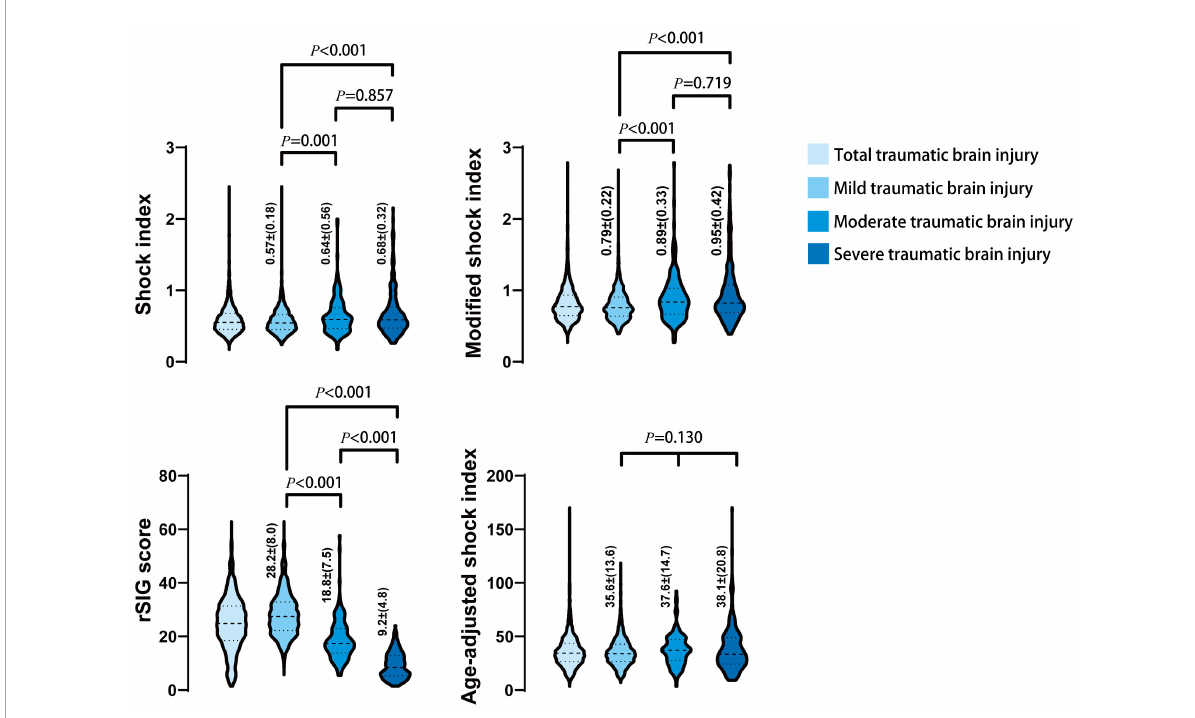
FIGURE3 The distribution and density of four prediction score systems in different severity of traumatic brain injury groups was illustrated in violin plot. Inside the violin plot interquartile ranges and outlier whiskers are presented as a thick and thin line equivalent to a boxplot. The detail score of shock index, modified shock index, rSIG, and age-adjusted shock index, in mild, moderate, and severe TBI was showed beside each violin as mean ± (standard deviation).